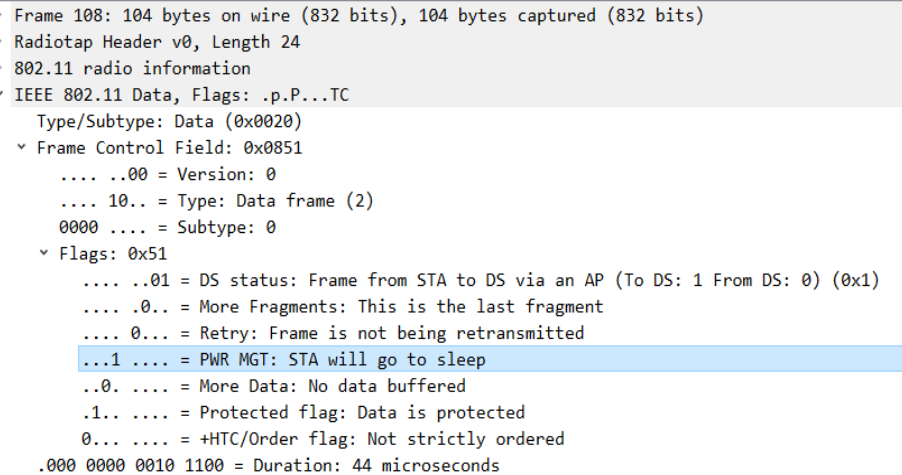
Figure 11. Data packet with PM enables sniffer capture with battery status.